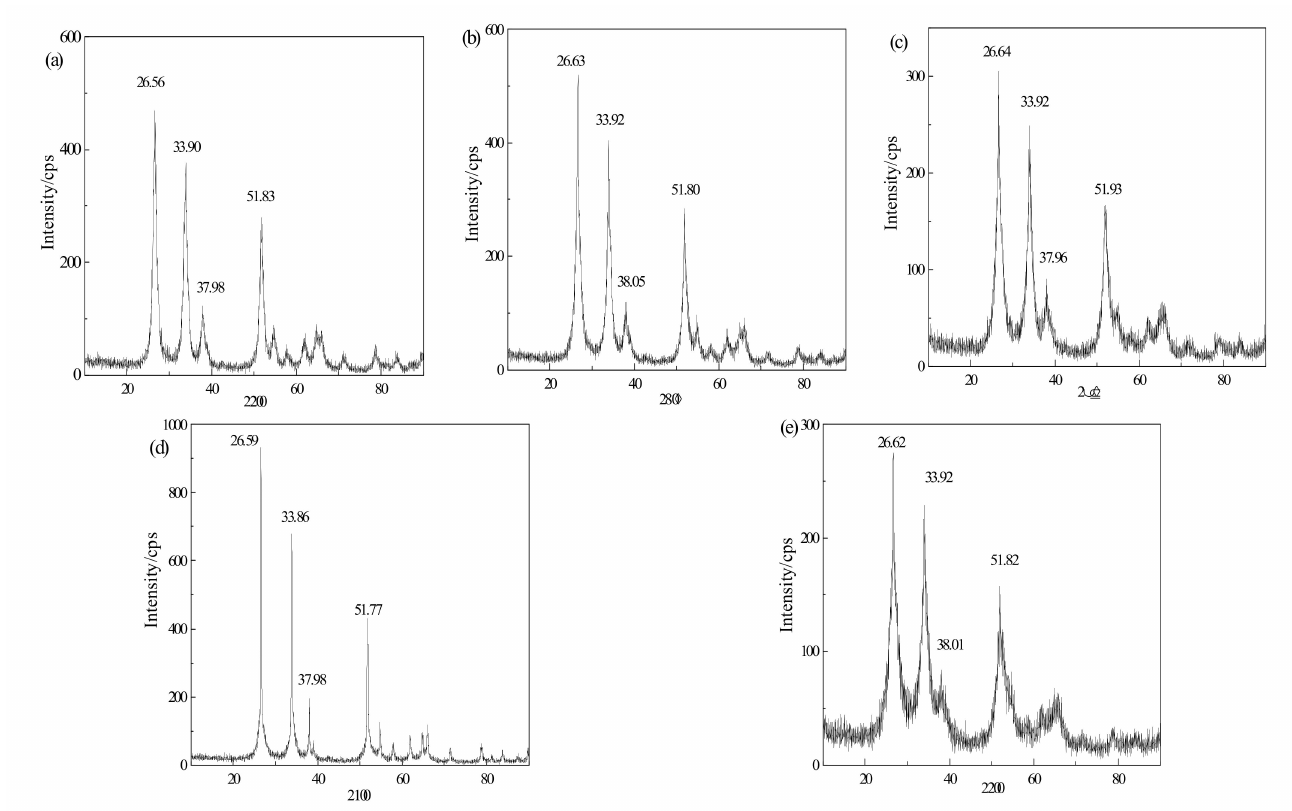
Figure 4. X-ray diffraction pattern. ( a ) x = 0; ( b ) x = 0.083; ( c ) x = 0.125; ( d ) x = 0.167; ( e ) x = 0.25.